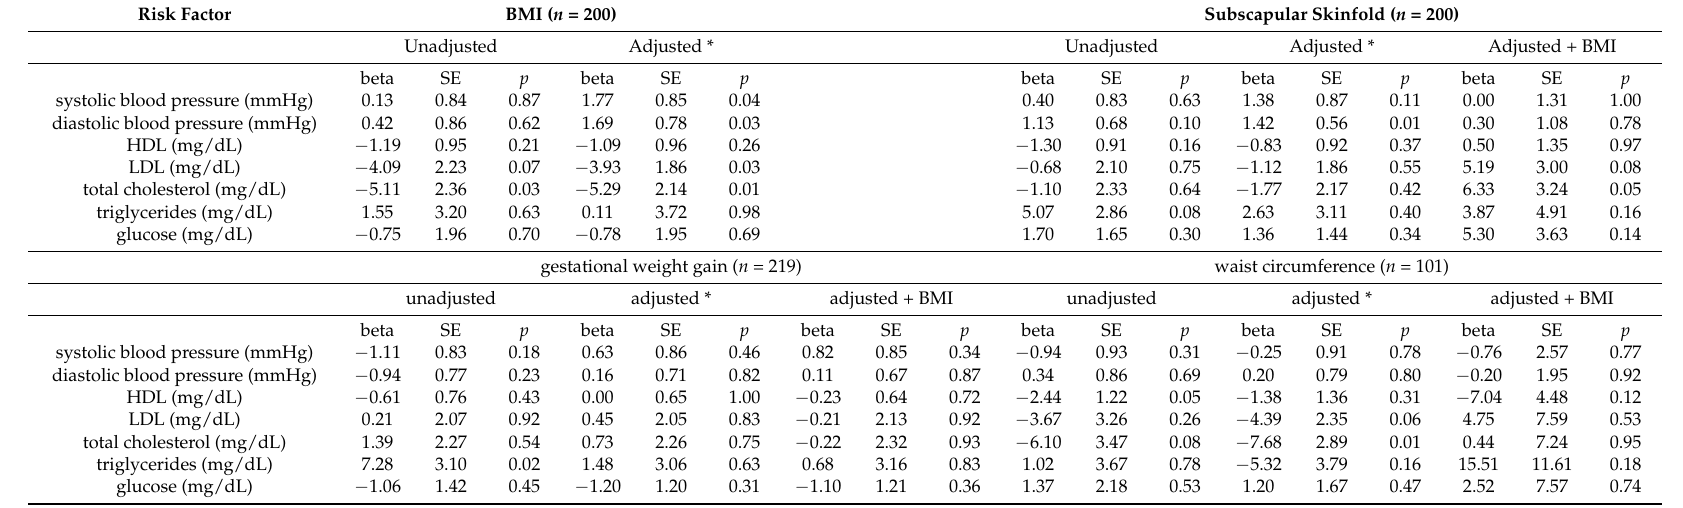
Table 3. Maternal adiposity as a predictor of child cardiovascular risk, the Bogalusa Daughters